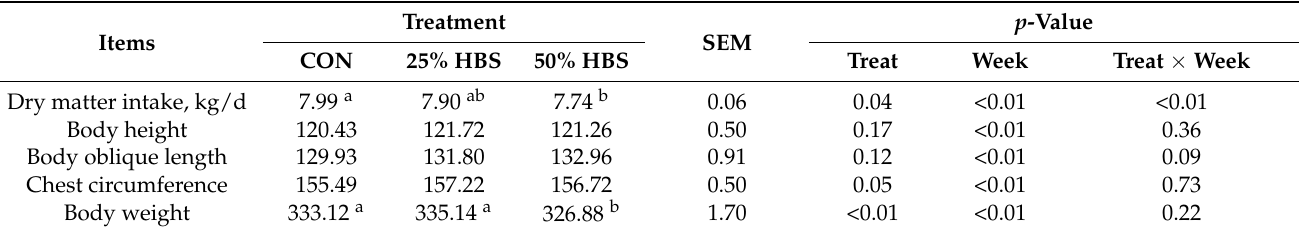
Table 2. Effect of different proportions of hydroponic barley seedlings replacing oat hay on body size indexes and body weight of heifers.